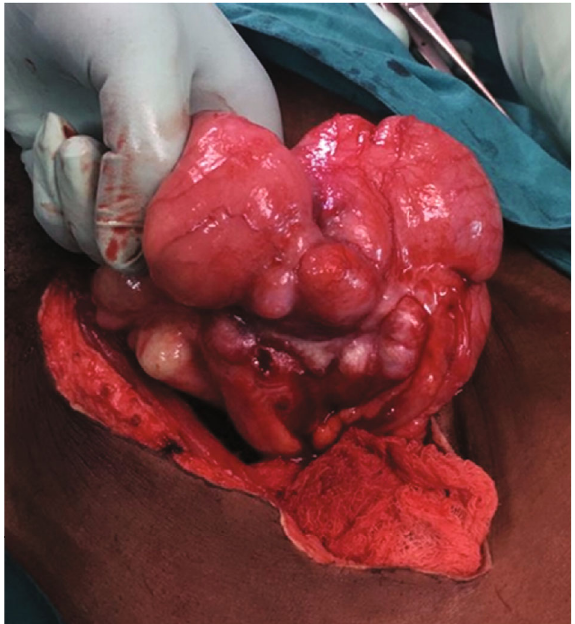
Figure 3: Caecal mass observed at